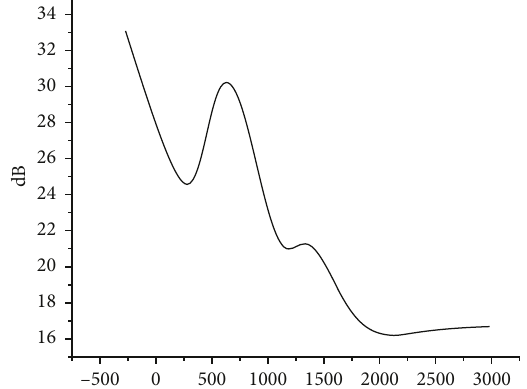
Figure 2: The catching curve of the floor slab of an ordinary residential district (mao embryo house).